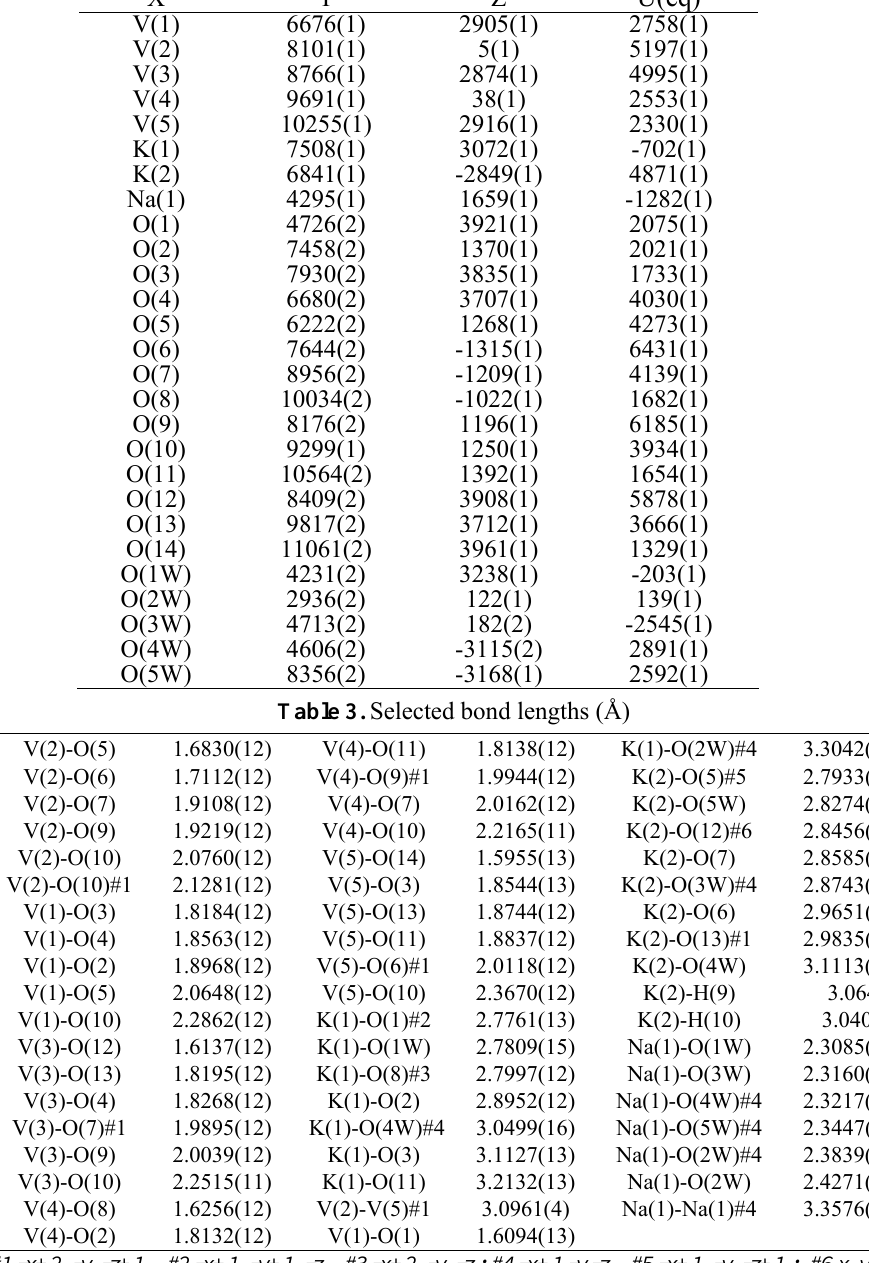
Table 2. Atomic coordinates ( × 10 4 ) and equivalent isotropic displacement parameters